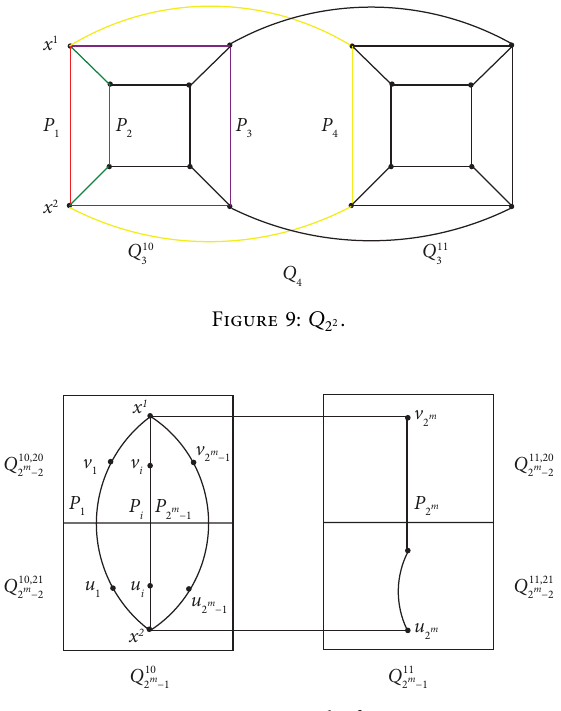
( x 1 , x 2 ) ≤ 2 m − 1 of Lemma 7. Q 2 m